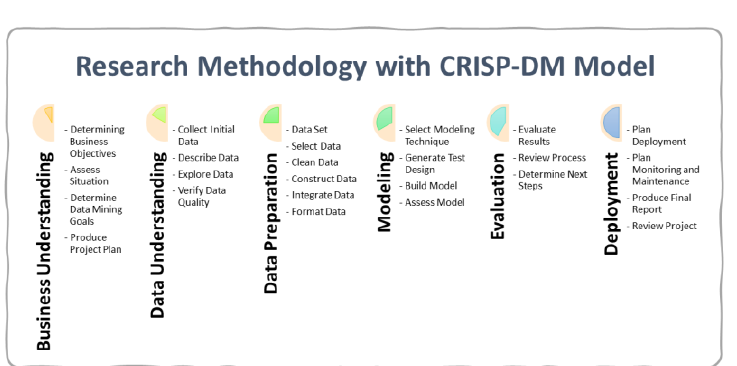
Fig. 2. Research Methodology with CRISP-DM